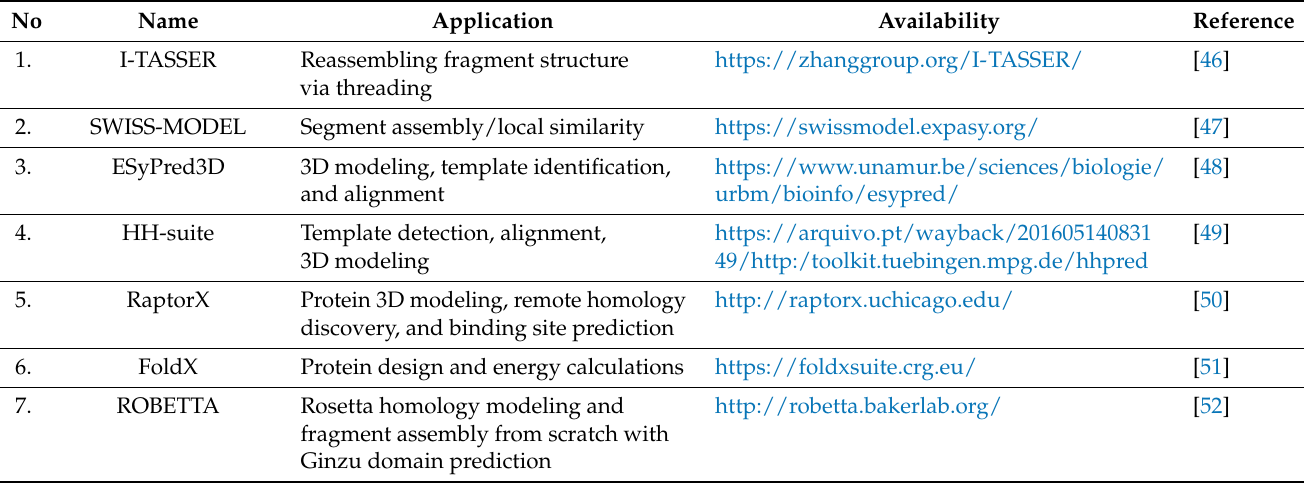
Table 1. Summary of the most widely recognized homology modeling tools use in drug